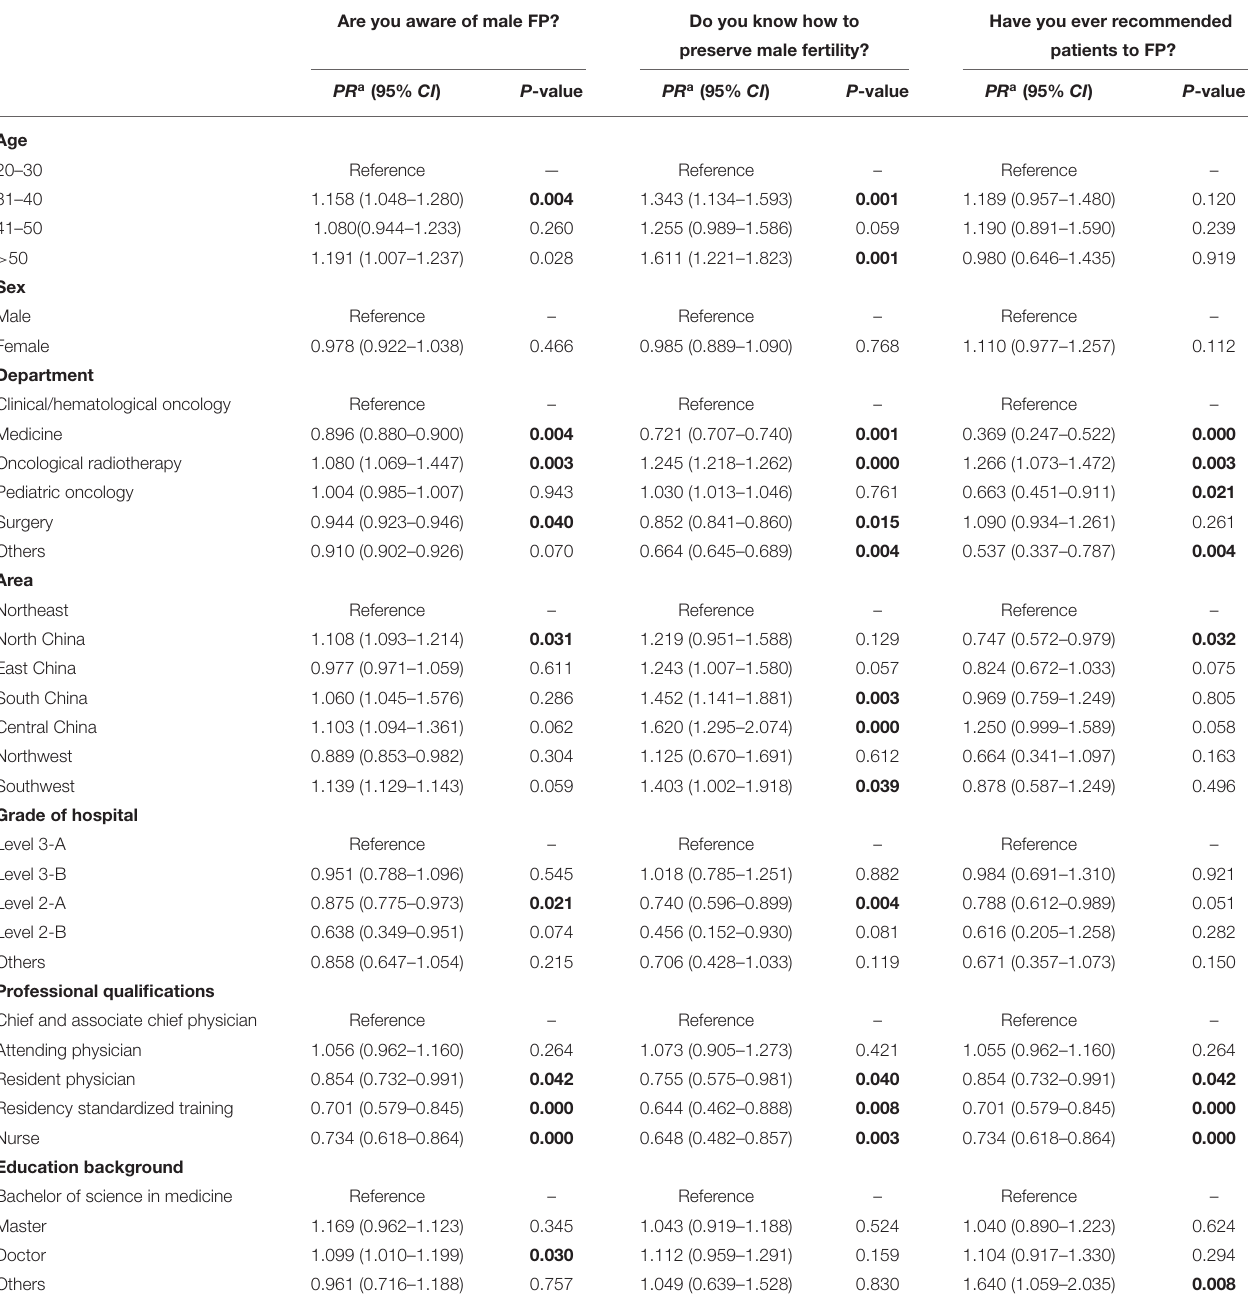
TABLE 4 | Log-binomial regression models analysis of male fertility preservation cognition and practice by different characteristics of